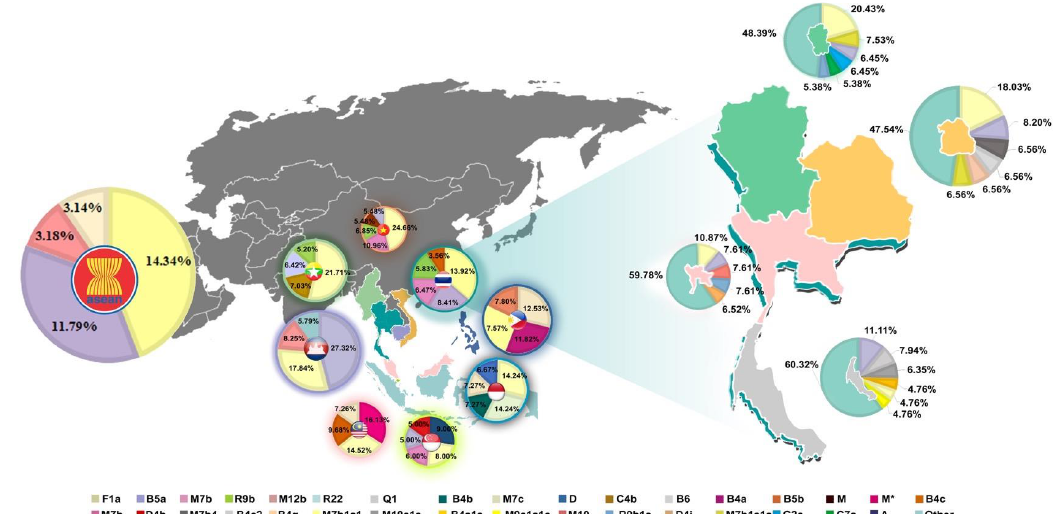
Figure 2. Haplogroup diversity observed in the Thai population ( n = 309) compared with Asian populations. Haplotype frequency of each Asian population was derived from Maruyama et al. [11], Li et al. [16], Yao et al. [21], Lee et al. [23], Summerer et al. [36], Tabbada et al. [39], Maruyama et al. [40], Zhang et al. [41], Shee et al. [42], Fornarino et al. [64], and Mona et al. [65].